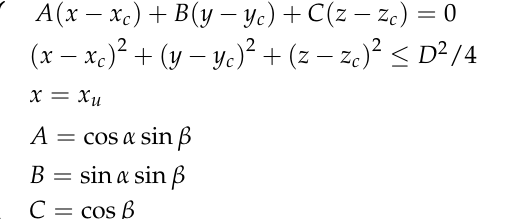
Table 2. The validation of the optimal model by comparing the surveyed data and simulated data.